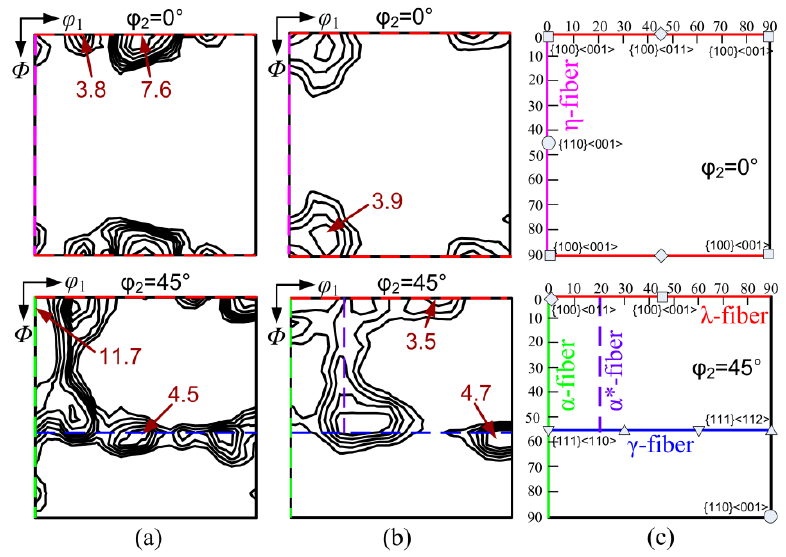
Figure 6. Macro-texture of OCR sample after ( a ) cold rolling and after ( b ) final annealing, and ( c ) major orientations and fibers on φ 2 = 0° and φ 2 = 45° sections of ODFs.